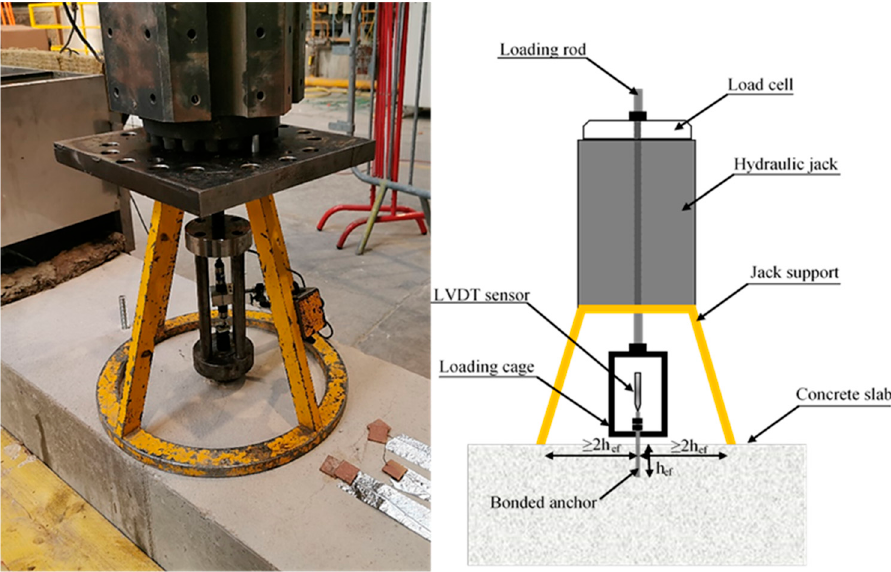
Figure 2. Test setup for tension tests at ambient temperature and after slow-rate heating.